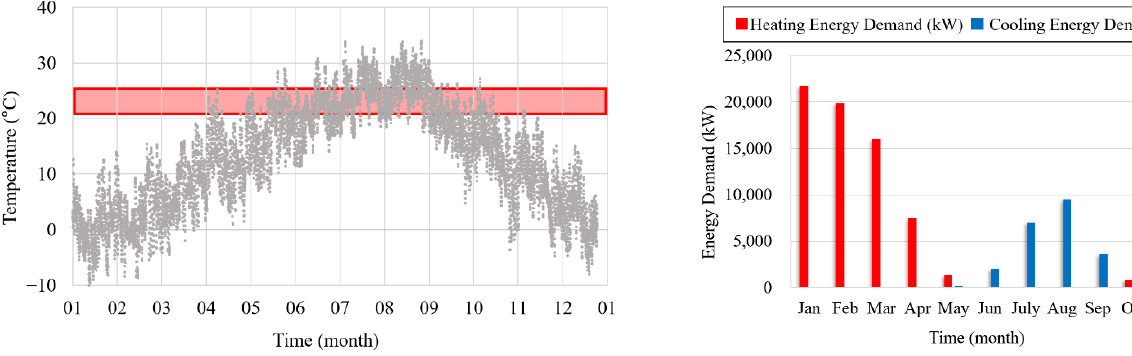
Figure 5. Ambient air temperature and monthly building loads in a large office building; ( a ) ambient air temperature in Busan, South Korea and setpoint temperature boundary of large office building, ( b ) monthly heating and cooling loads in a large office building in Busan, South Korea.